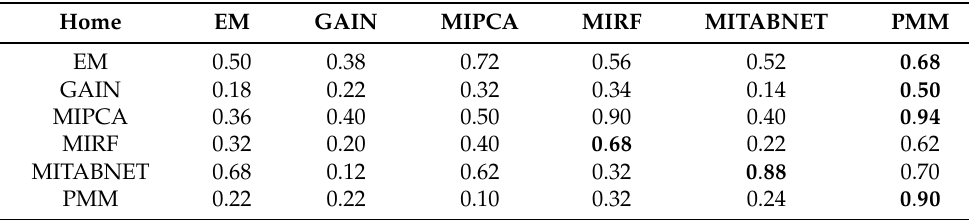
Table 6. Coverage for each imputation algorithm in the Flatiron NSCLC dataset.